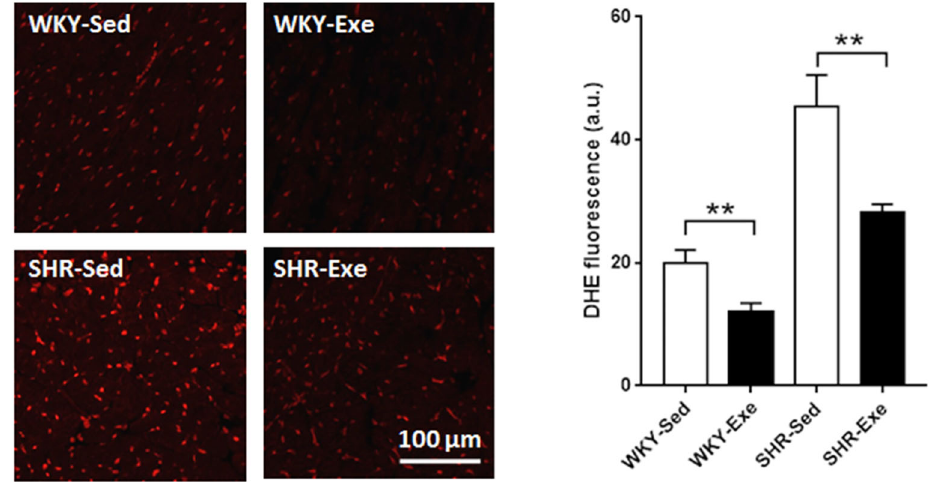
Figure 3. Cardiac reactive oxygen species levels were determined in sedentary or exercised Wistar-Kyoto rats (WKY + Sed, WKY + Exe) and in sedentary or exercised spontaneously hypertensive rats (SHR + Sed and SHR + Exe) by dihydroethidium staining after 16 weeks of moderate-intensity exercise. Representative images and statistical histogram are shown. Data are reported as means ± SE (n=4). **P o 0.01 (ANOVA). Scale bar: 100 m m.